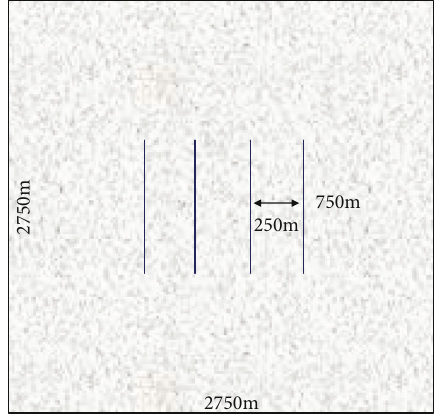
Figure 3: Schematic diagram of the physical model.